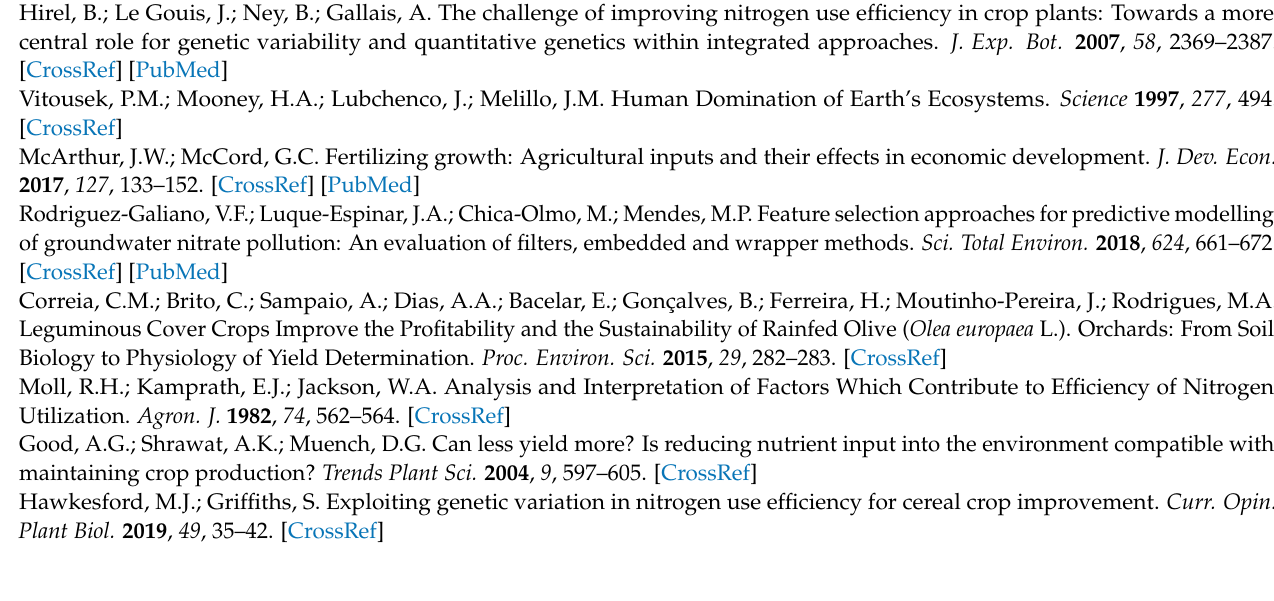
LSD. Differences between genotypes at the same time marked in yellow. Marked in green, the different times. Table S5—Results from pathway analysis are presented in a detailed table, from letter “A–F” the pairwise comparison about genotypes. Table S6—KEGG reference pathways, a subset of 121 genes were obtained overall. Table S7—Pearson’s correlation coefficient (A) and p -value (B) of accession-specific metabolites and metabolic genes. Table S8—Pair comparisons: variables with significantly altered levels are indicated in detailed data table (FDR p-adjusted < 0.05). Variables with LOG2 (FC) ≥ ± 1 are marked in yellow. (A) T0, (B) T1, and (C)